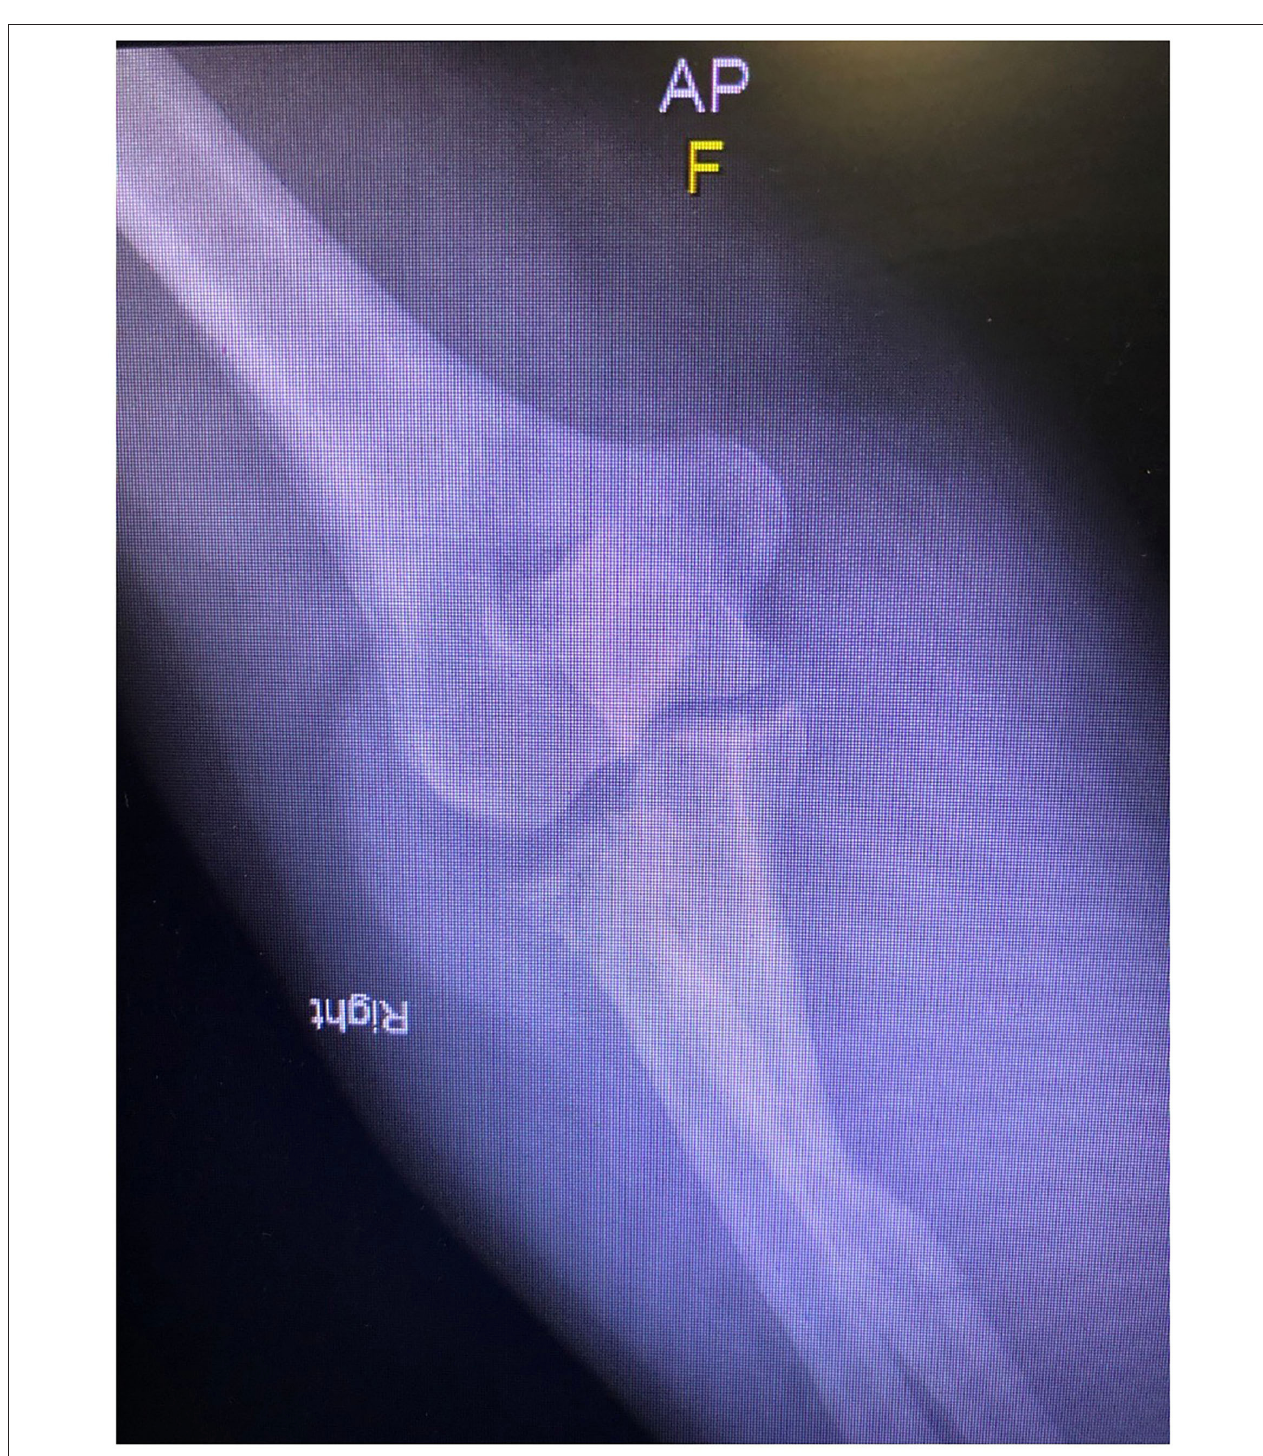
FIGURE 1 | Preoperative elbow AP view of a complex elbow trauma.